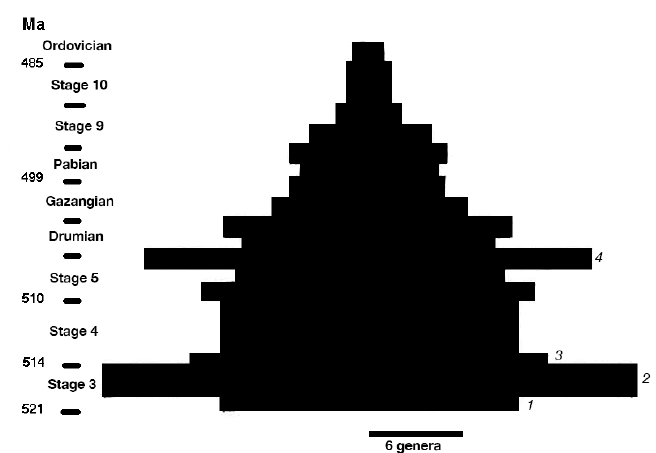
Figure 2. Genus-level bradoriid diversity during the Cambrian and Ordovician. Geological dates in million years ( Ma ). Stages refer to stages of the Cambrian. Numbers to the right indicate diversification waves 1–4. Data from [2] and “Bradoriid Genera” section